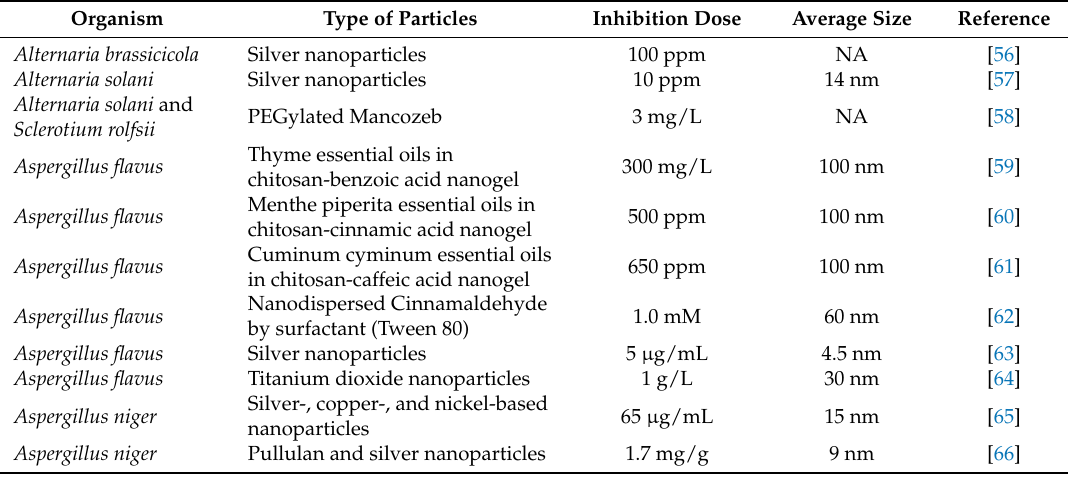
Table 1. Antifungal nanoparticles synthetized by the chemical